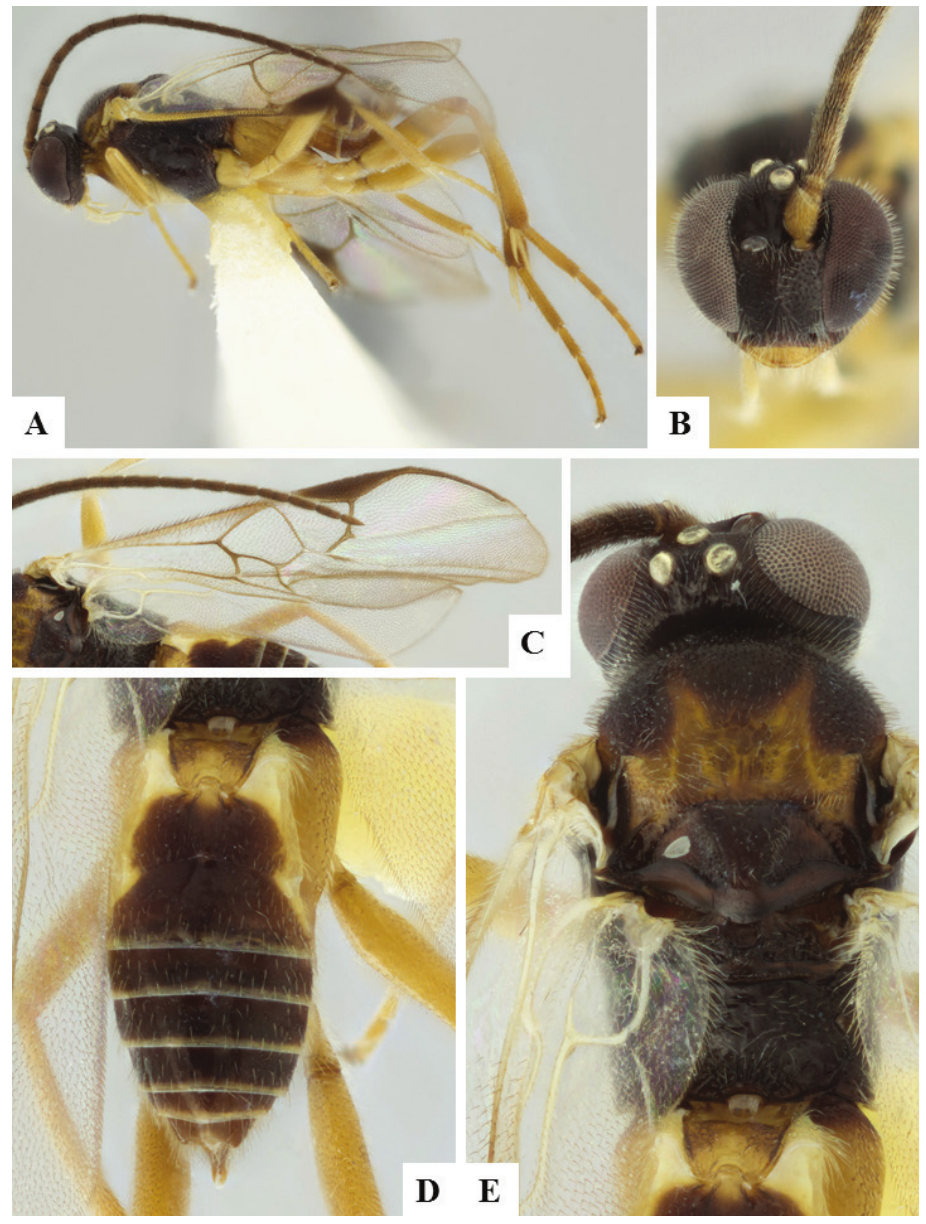
Figure 18. Distatrix carolinae. A Habitus, lateral B Head, frontal C Wings D Metasoma, dorsal E Head and mesosoma,